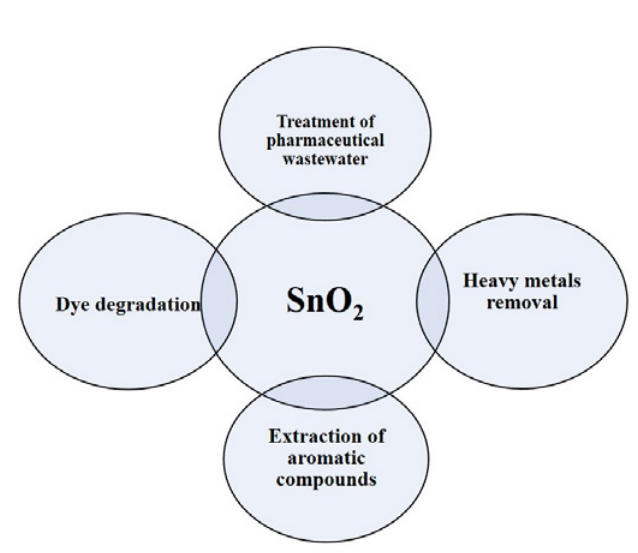
Fig. 7. Applications of SnO